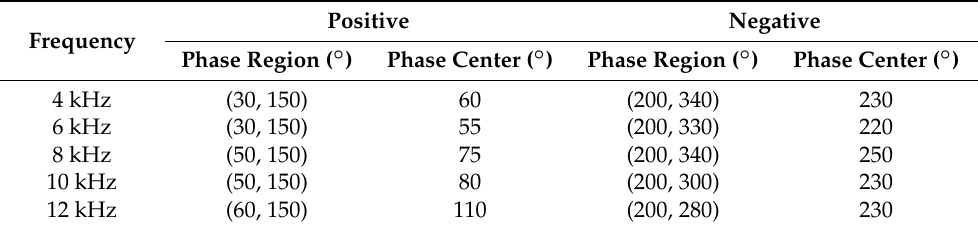
Figure 11. PD N ‐Φ Spectrogram at different frequencies. Table 1. The partial discharge (PD) phase region and displacement phase center at different frequencies.